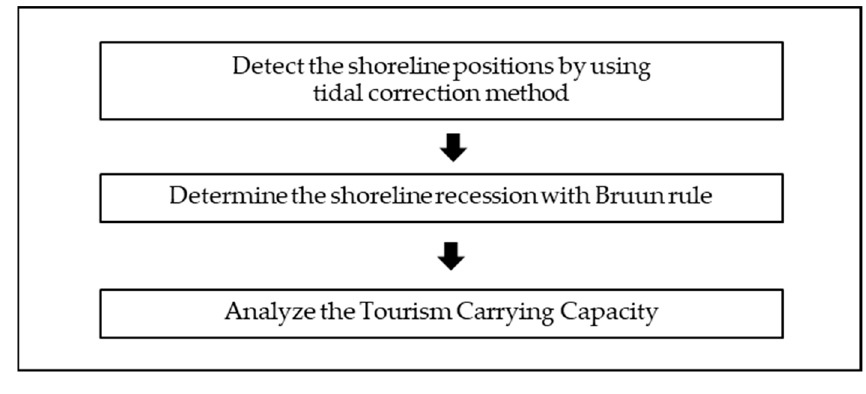
Figure 4. Flow chart.